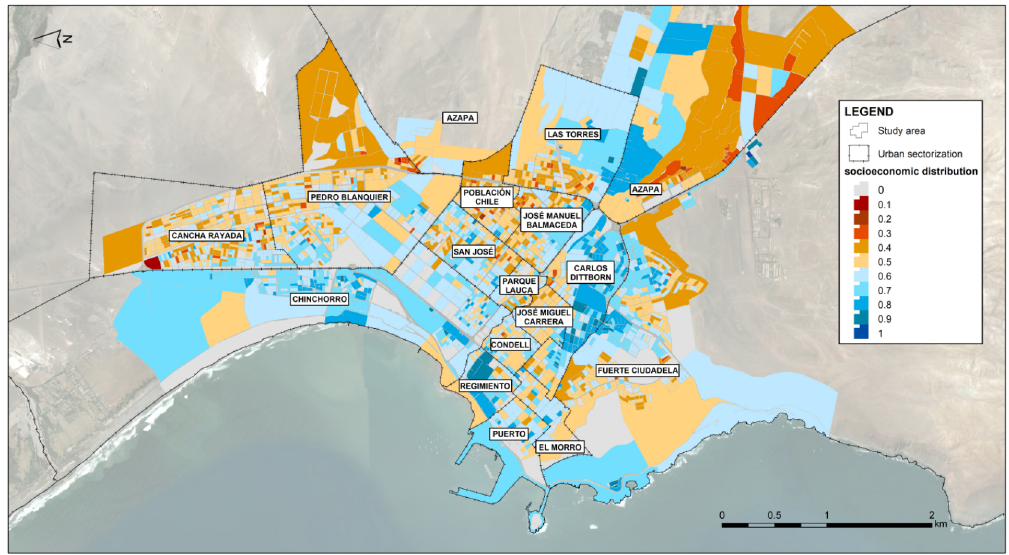
Figure 6. Distribution of socioeconomic ranks in Arica, according to their location in urban sectors. The spatial distribution of low TWi, which represents those blocks with a low socioeconomic classification, shows that the most significant amount of data was found in the urban sectors of Cancha Rayada with eighty-nine blocks and 0.7 km 2 , Pedro Blanquier with fifty-nine blocks distributed over 0.4 km 2 , and Fuerte Ciudadela with fifty census blocks totalling 0.8 km 2 . On the other hand, the lowest concentration of data was located in the Condell district with four blocks, Chinchorro with two, and Puerto, El Morro, and Regimiento with one census block in each sector, with a total of less than 0.01 km 2 in these five zones. These values are concentrated in the eastern sector of the study area, leaving little range data in the western zone (Supplementary Figure S1). Regarding the spatial distribution of high TWi, representing the blocks with high socioeconomic classification, it can be mentioned that the largest amount of data was found in the urban sectors of Carlos Dittborn with sixty blocks and 0.5 km 2 , Chinchorro with fifty-two blocks distributed over 0.3 km 2 , and Fuerte Ciudadela with twenty-eight census blocks adding up to 0.1 km 2 . On the other hand, the lowest concentration of data was located in the Condell districts with three blocks distributed over 0.4 km 2 , Poblaci ó n Chile with two blocks, and Parque Lauca with one census block, both over less than 0.01 km 2 . Contrary to the previous case, the highest concentration of data occurred in the southwestern and southeastern areas of the city and to a lesser extent in the northern part of the city (Supplementary Figure S2).